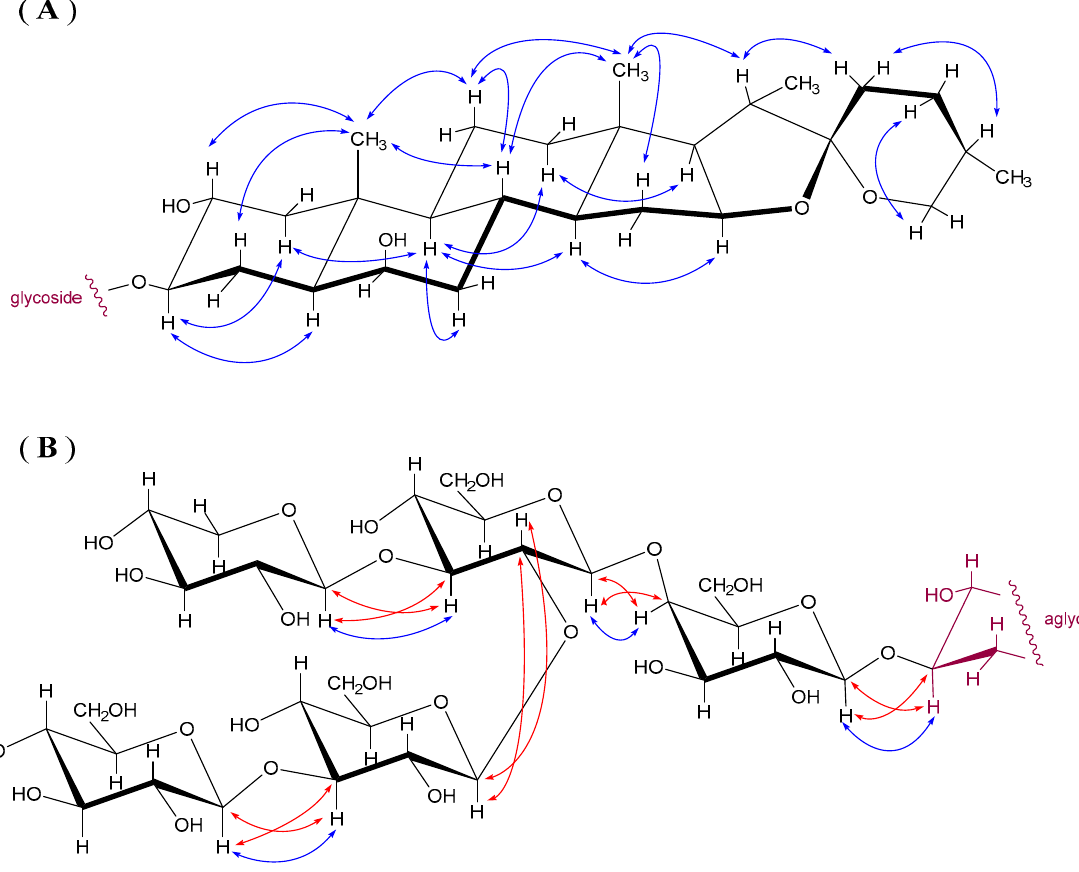
Figure 4. Selected NOE contacts (blue arrows) and 3 J (C,H) (red arrows) observed in 2D-H,H-ROESY and 2D-H,C-HMBC spectra in CD 3 OD of alliporin, hereby identified as yayoisaponin A ( 3 ). ( A ) Aglycone: NOE contacts allow stereochemical assignment of methylene protons and prove the configuration at chiral centres. ( B ) Glycosidic part: NOE contacts and cross peaks in HMBC spectrum determining connection between hexapyranose units are shown. The 13 C and 1 H-NMR data are in Table 3.